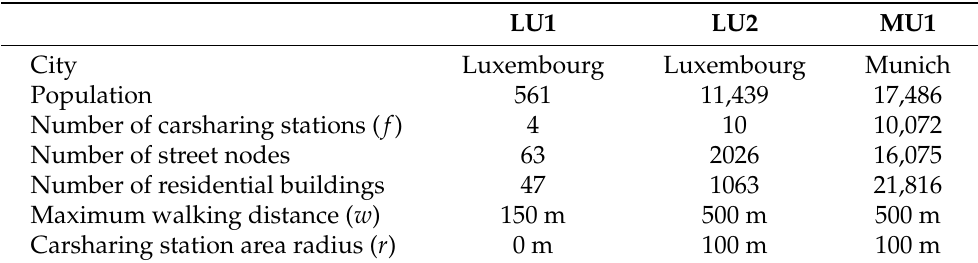
Table 4. Problem instances.